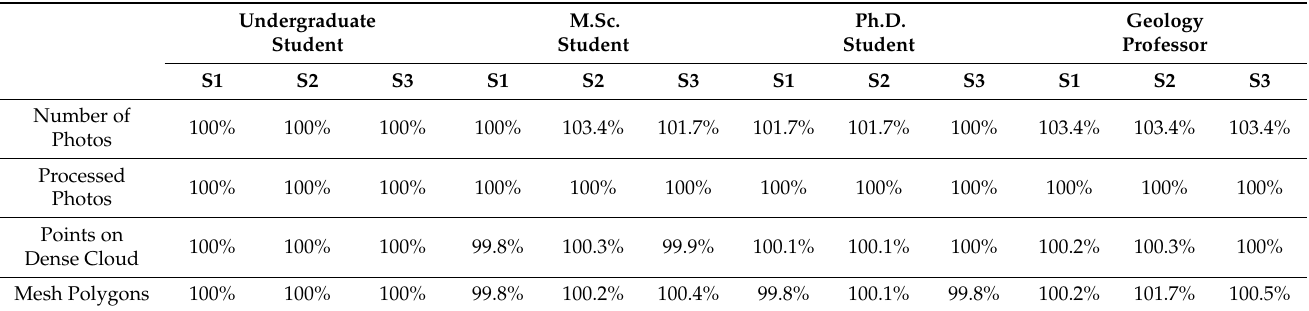
Table 8. Quantitative analysis after the methodological